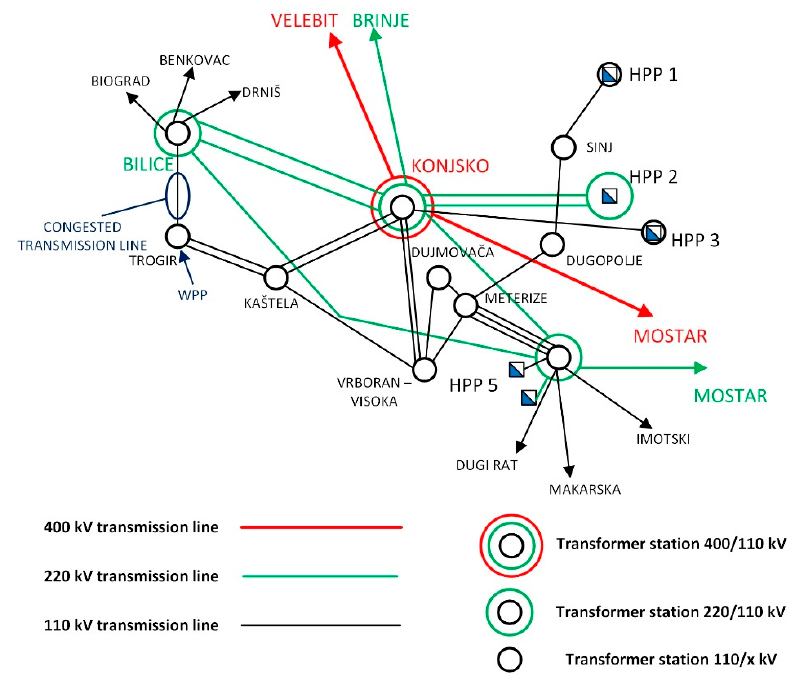
Figure 7. The southern part of the Croatian transmission system